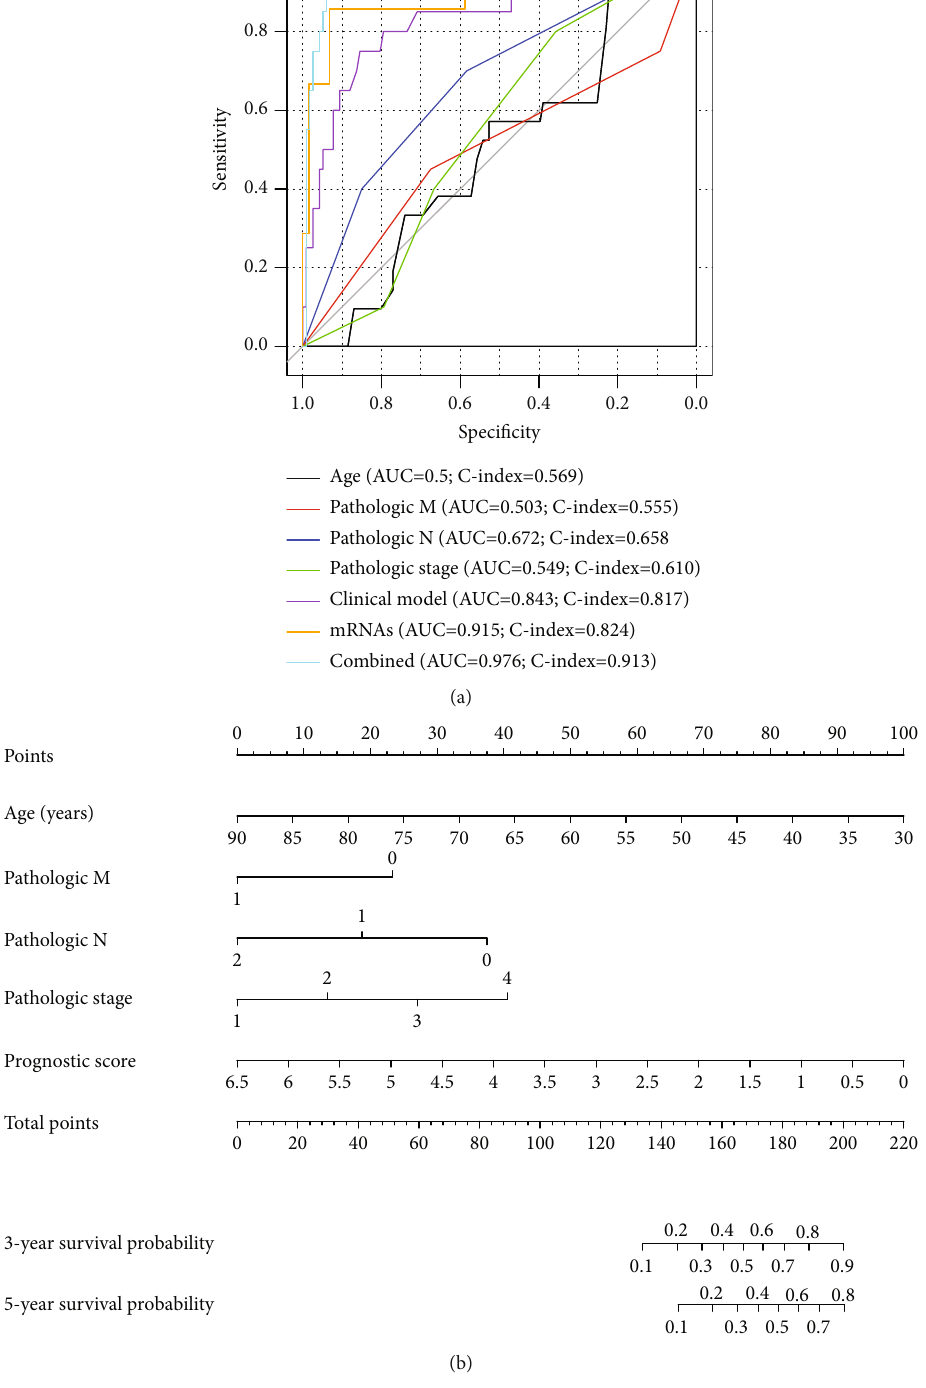
Figure 6: A prognostic nomogram to predict the survival probability of patients with rectal cancer. (a) Receiver operating characteristic curve to demonstrate the superiority of the risk score for the prognosis prediction to other clinical factors. (b) A prognostic nomogram. AUC: area under the receiver operating characteristic curve; C-index: concordance